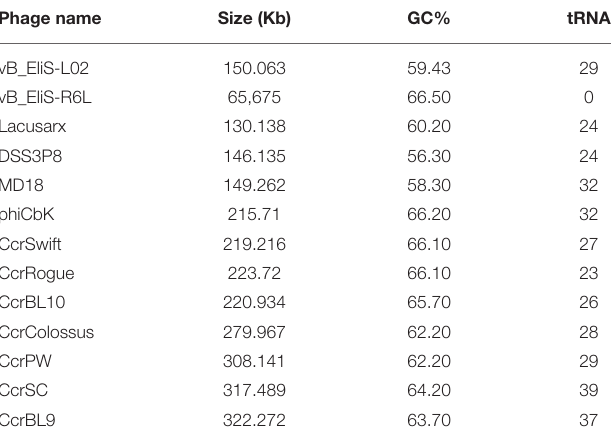
TABLE 2 | Genomic features of phage vB_EliS-L02, phage vB_EliS-R6L, and other Cbk-like siphoviridae